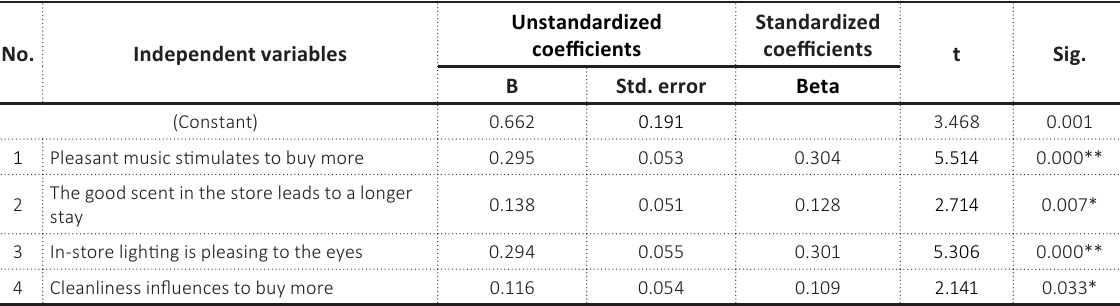
Table 13. Regression analysis of the impact of store ambiance on impulse buying behavior No.